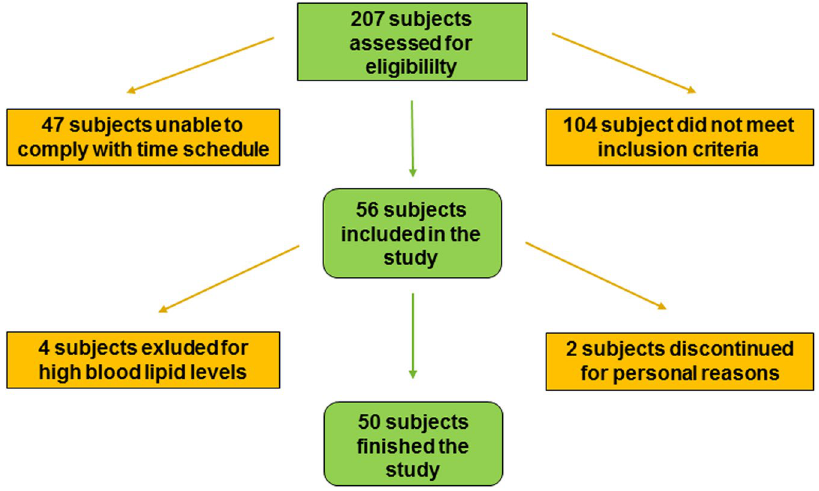
Figure 1. Flow-chart of the study.